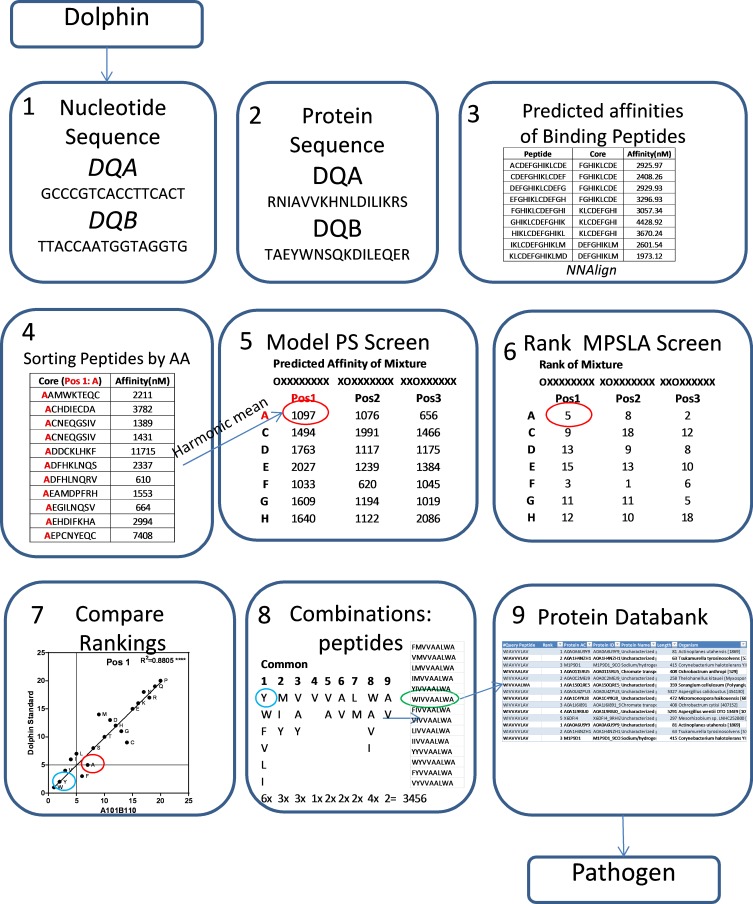
Method for model positional scanning library analysis (MPSLA).Nine steps that take the researcher from genetic sequence data, through MHC binding analysis, to protein and pathogen prediction.